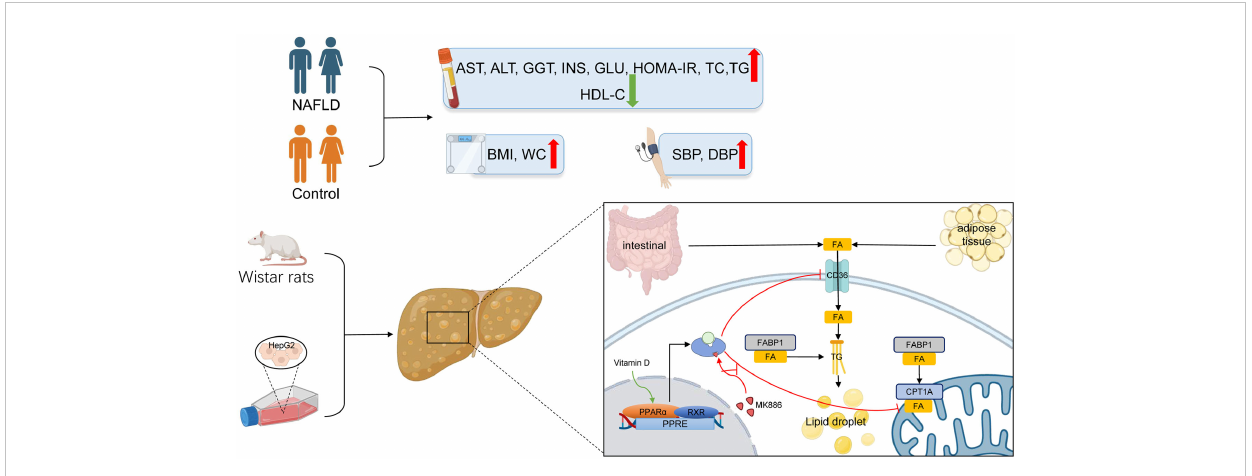
FIGURE 7 The lipid mechanism of NAFLD and anti-lipid accumulation mechanism of VD associated with PPARa pathway. Patients with NAFLD exhibited higher BMI, WC, SBP, DBP, AST, ALT, GGT, ALP, INS, GLU, HOMA-IR, TC, TG, LDL-C and lower HDL-C. The increased lipid oxidation and lipid uptake related proteins by VD treatment were inhibited after the application of MK886 in vivo and in vitro